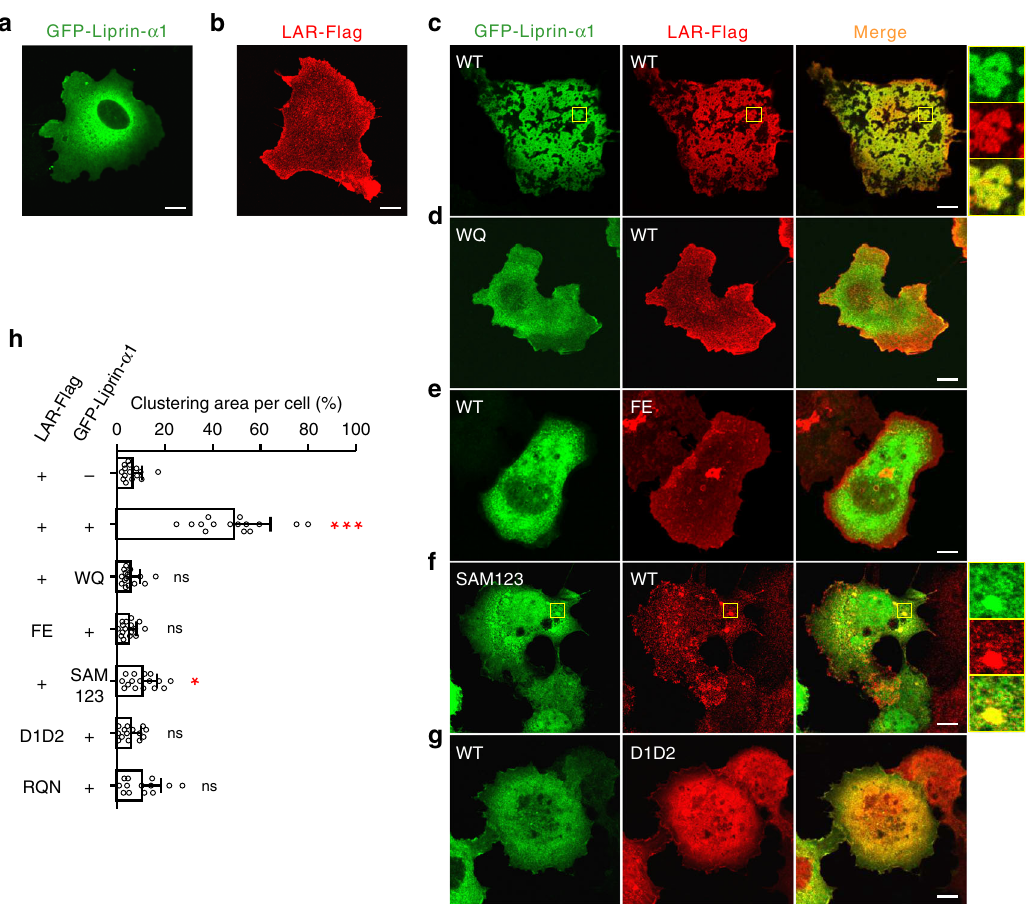
Fig. 3 Liprin- α promotes the clustering of LAR. a , b Cell imaging of over-expressed N-terminal GFP-tagged liprin- α 1 ( a ) and C-terminal Flag-tagged LAR ( b ) in COS7 cells. c – g Cells co-transfected with GFP-tagged liprin- α 1 wild-type or its variants and Flag-tagged LAR or its variants. Regions of interesting were highlighted by yellow boxes, enlarged four times, and aligned on the right of each merged image. “ WQ ” and “ FE ” indicate the W896Q mutant of liprin- α 1 and the F1829E mutant of LAR, respectively. Scale bar, 10 μ m. h Quanti fi cation of the LAR clustering levels as shown in ( a – g ) and in Fig. 4c. Error bars represent s.d. ~15 cells per experimental condition. The unpaired Student ’ s t test analysis was used to de fi ne a statistically signi fi cant difference (* p < 0.05; ** p < 0.01; *** p < 0.001; ns not signi fi